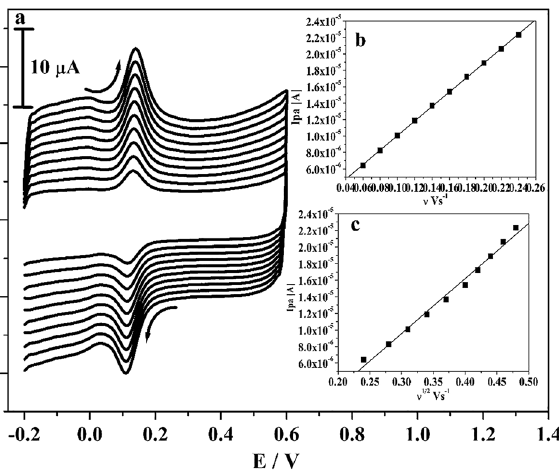
Figure 6. ( a ) CVs curve for 10 µM CC at poly(CBBG)/MCPE with altered sweep rates (0.06–0.24 Vs −1 ) in 0.2 M PBS of pH 7.4. ( b ) Plot of Ipa versus scan rate. ( c ) Plot of Ipa versus square root of scan